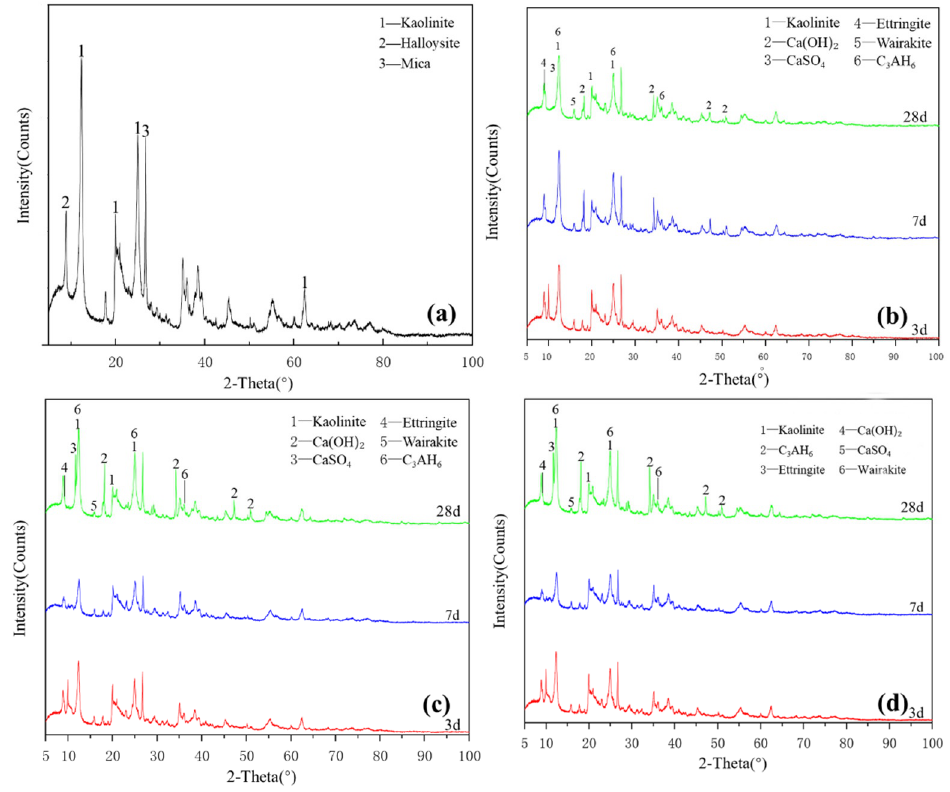
Figure 2. XRD patterns of kaolinite: ( a ) raw material, ( b ) 3-, 7- and 28-day curing age G0, ( c ) 3-, 7- and 28-day curing age G1, ( d ) 3-, 7- and 28-day curing age G1-2.